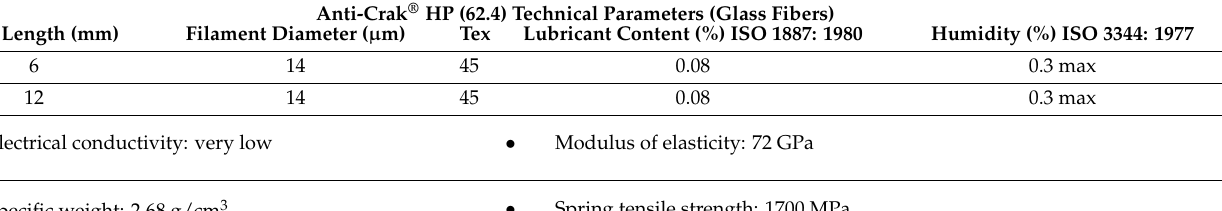
Table 2. Technical parameters of Anti-Crack HP (62.4) glass fibers.